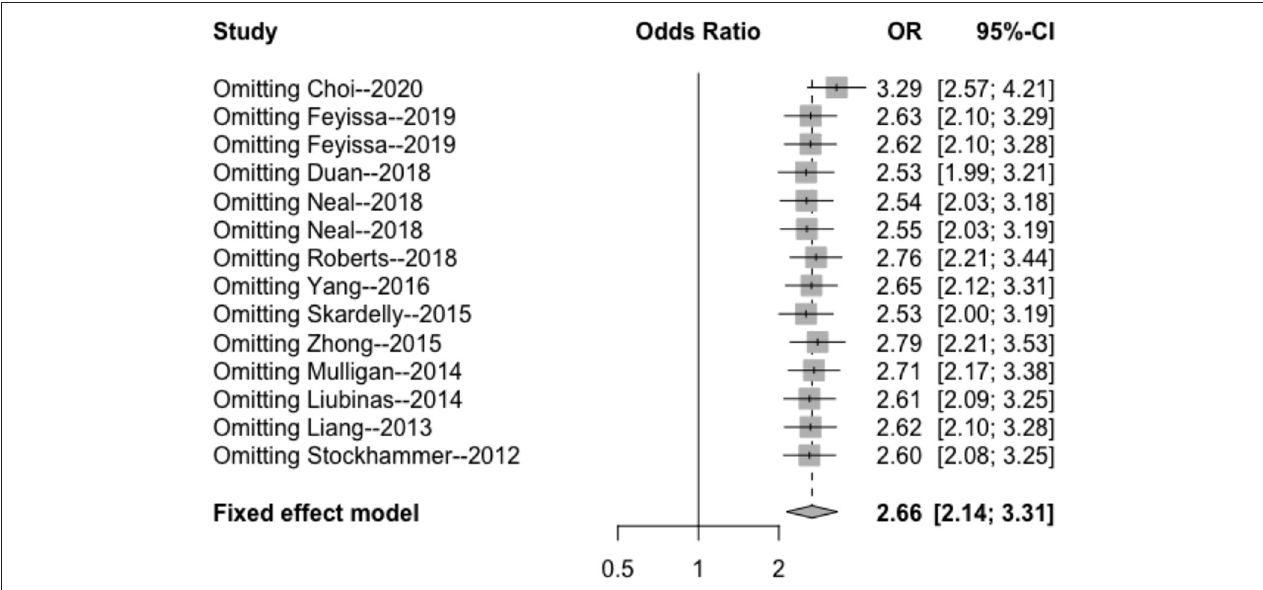
FIGURE 7 | Sensitivity analysis of the correlation between IDH mutation and perioperative epilepsy. CI, confidence interval; IDH, isocitrate dehydrogenase; OR, odds ratio.